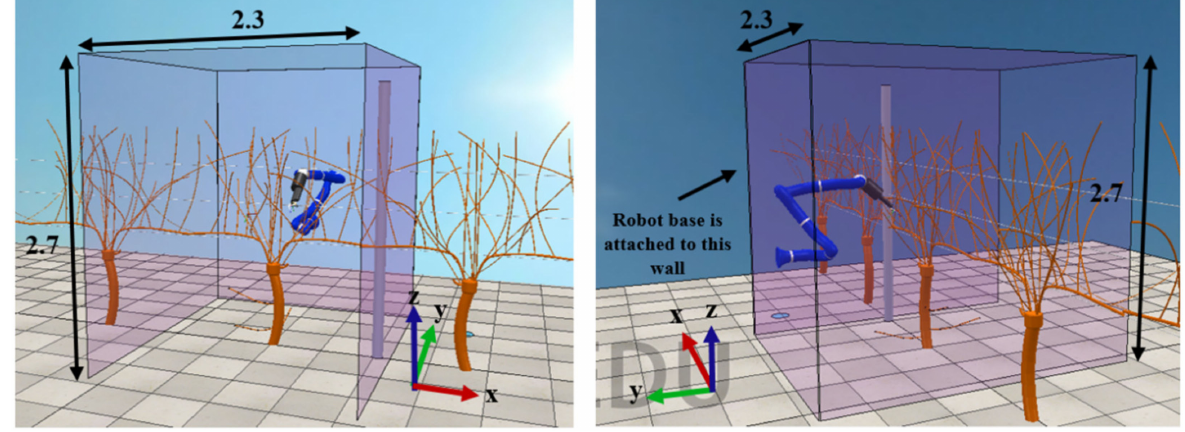
Figure 9. Prubot’s task space (lengths are in meters).